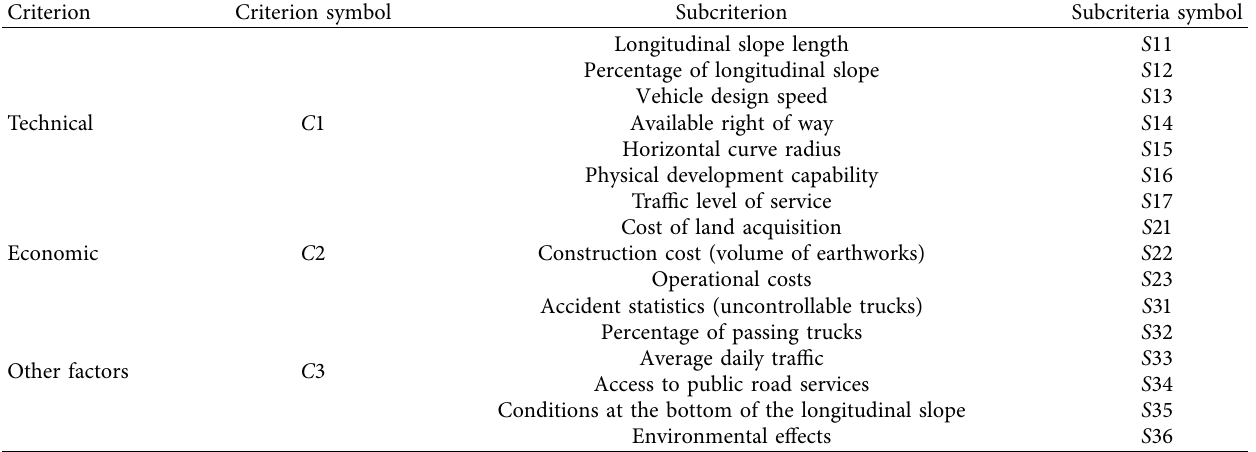
Table 2: Criteria and research options.